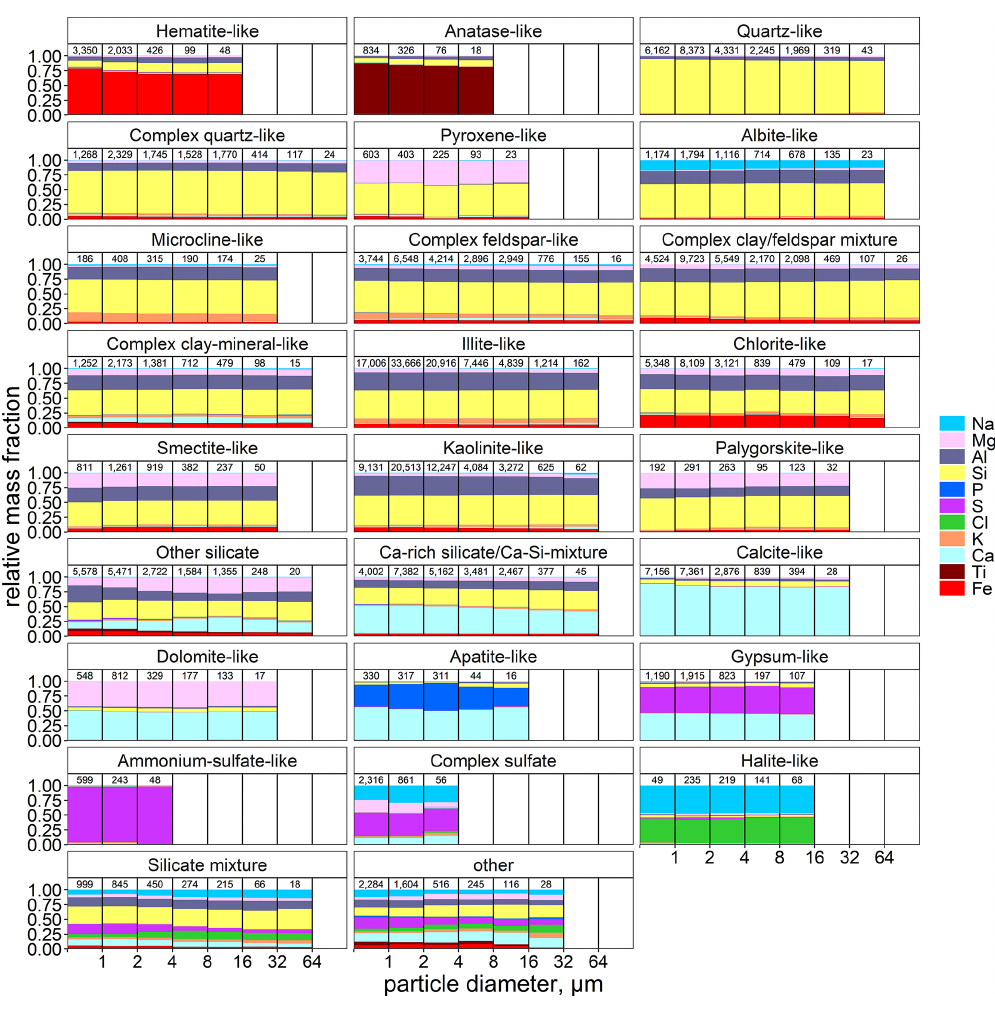
Figure 2. Average elemental composition as a function of particle size for different particle groups. The legend shows element index for each respective element. The numbers on top represent total particle counts in the given size bin. Abundance bars are not shown for size bins with fewer than 10